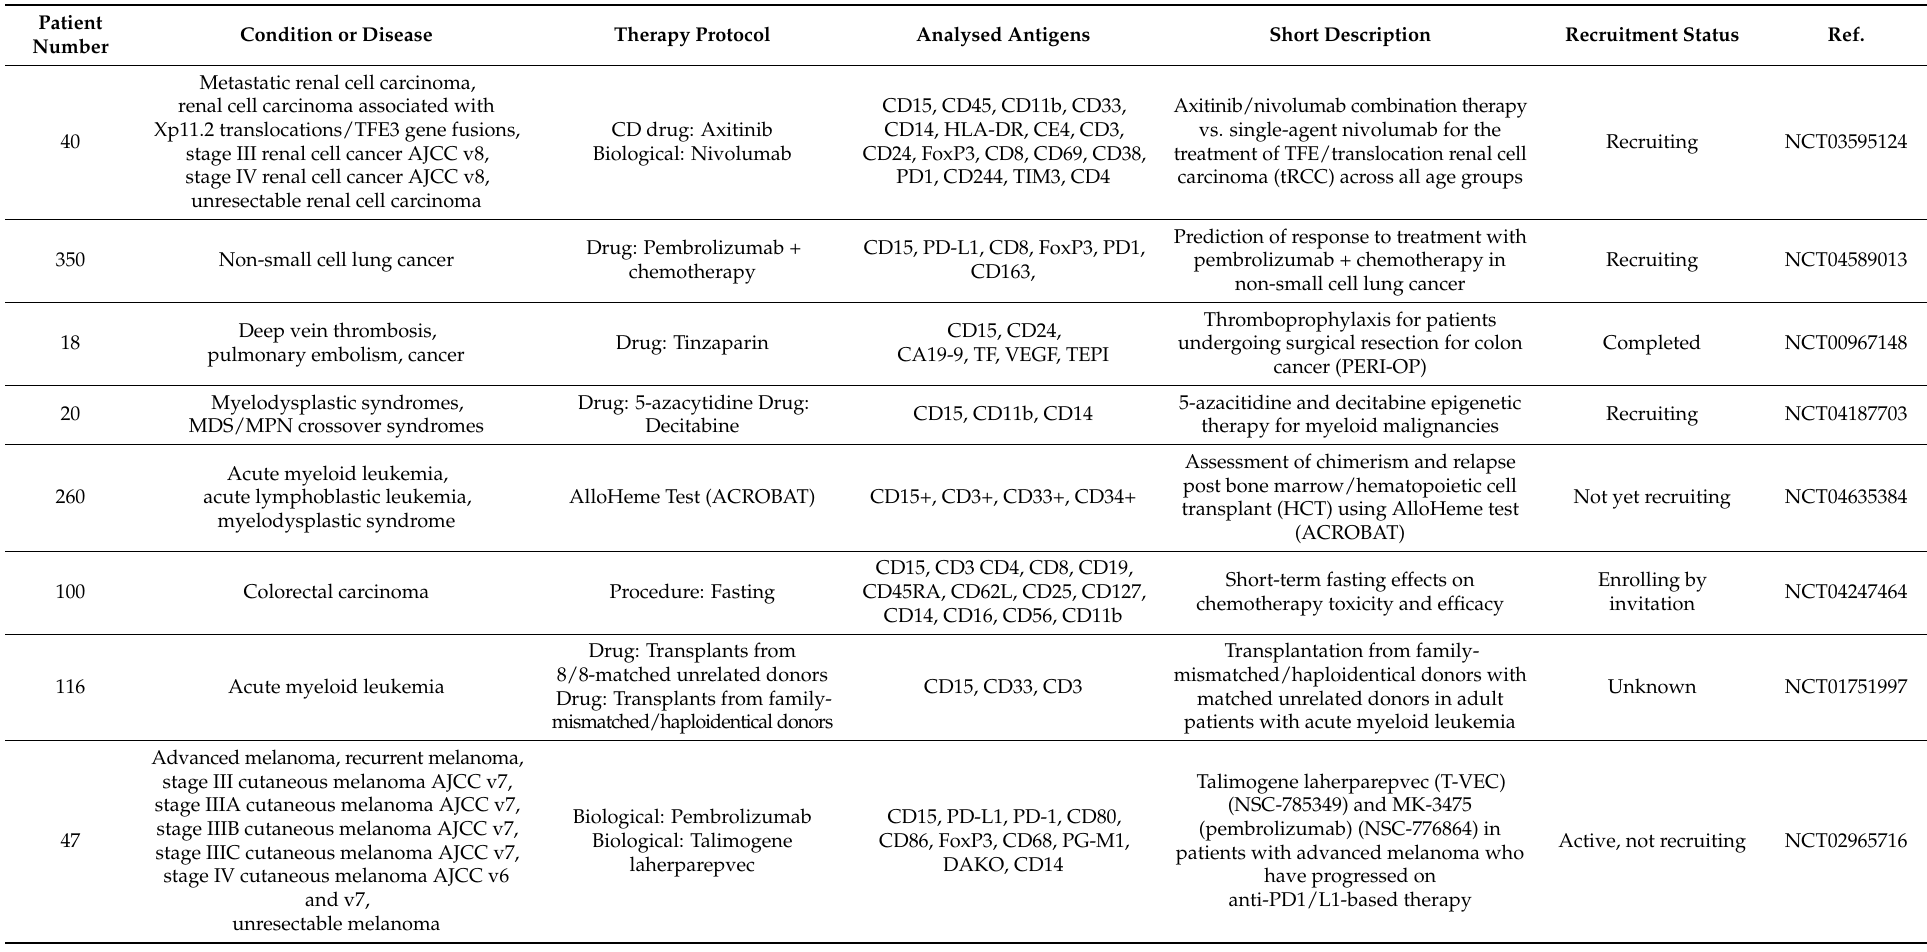
Table 1. Clinical trials involving the CD15